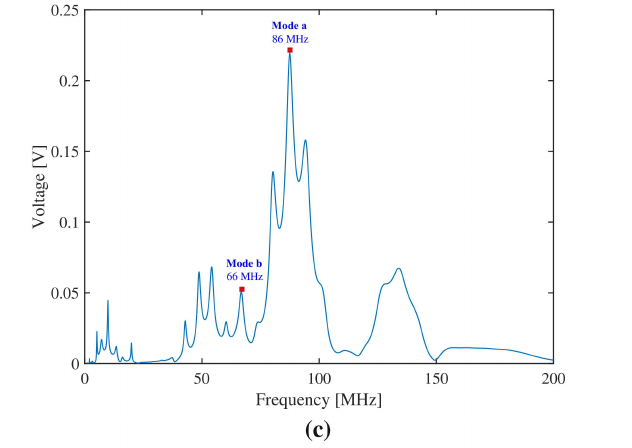
Figure 5. Mode a and mode b shown in output frequency spectrum for metalization ratios of ( a ) 10%, ( b ) 50%, and ( c )